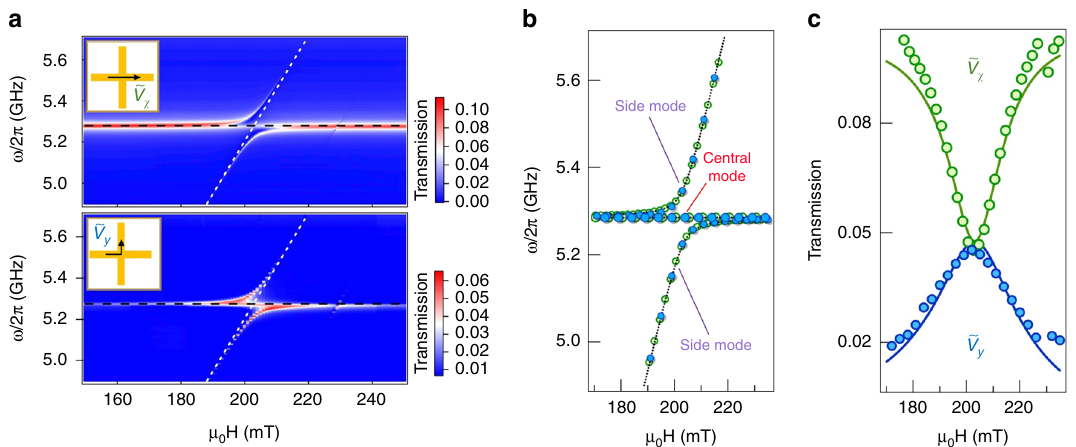
Fig. 4 X-CMP dispersion. a Amplitude mappings of ~ V x and ~ V y plotted as a function of applied magnetic fi eld measured for the con fi gurations shown in the inset. White dashed lines indicate the expected magnon dispersion according to Kittel ’ s formula and the black dashed lines show the cavity frequency. b Dispersion of the hybridized modes. c Resonance feature of the longitudinal signal ~ V x and the Hall signal ~ V y near ω m ¼ ω c , where the central mode is at ω ¼ ω c . In ( b , c ), symbols are experimental data deduced from ( a ) and the dashed or solid lines are the calculated results using Eq. (2)